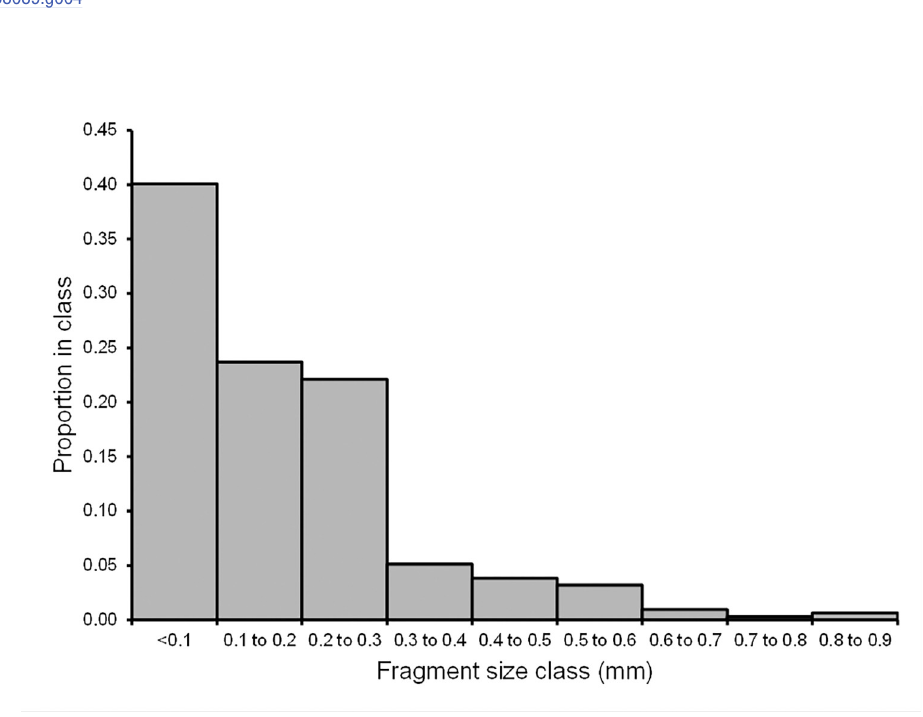
Fig 5. Size distribution of small metal fragments. Frequency distribution of the estimated diameters D of small metal fragments < 1 mm imaged in micro-CT scans. Bars show the proportions of 312 fragments in each 0.1 mm size class. No fragments in the range 1–2 mm were